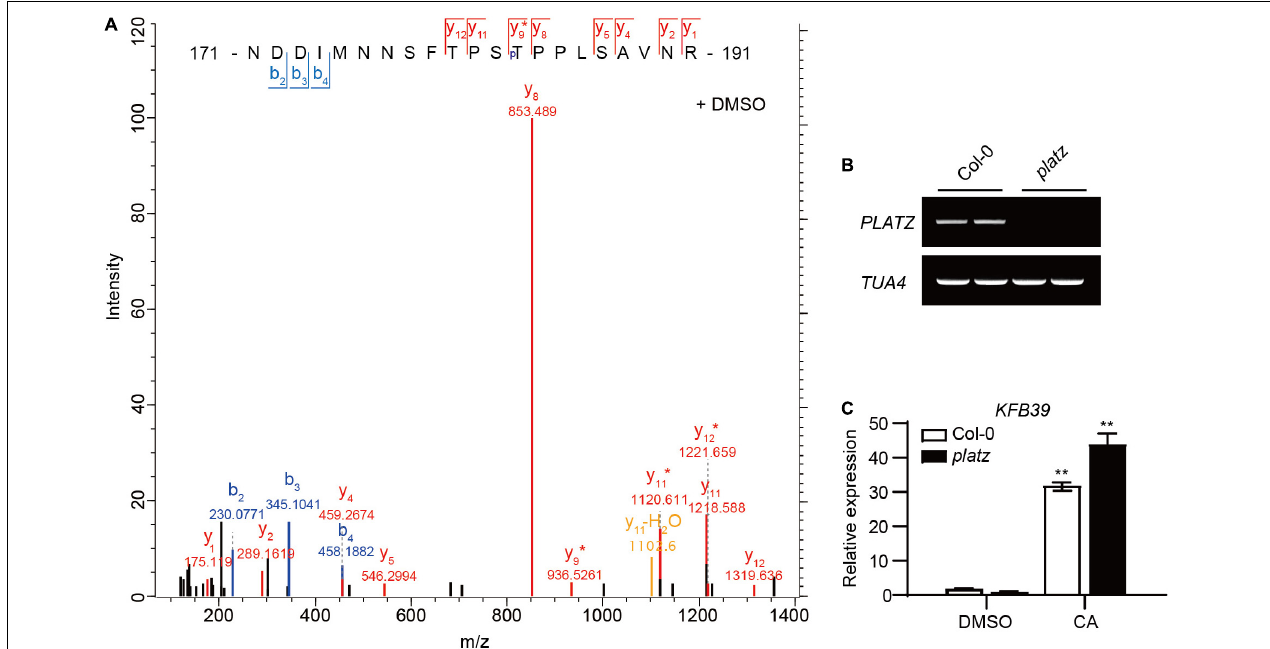
FIGURE 2 | Coniferyl alcohol can induce the up-regulation of KFB39 expression in platz . (A) Mass spectrometric analysis of PLATZ phosphorylation in vivo at Thr 183 in 2-week-old Col-0 seedlings treated with solvent DMSO for 1 h. (B) RT-PCR result showing that the platz was a knock-out mutant line for PLATZ . TUA4 was used as the positive control. (C) The expression level of KFB39 in 14-day-old Col-0 and platz seedlings treated with solvent DMSO or 0.1 mM CA for 30 min. All of the data represent average transcript level values ( ± SD) relative to corresponding DMSO-treated lines. Asterisks indicate a statistically significant difference between the treated and DMSO control groups (Student’s t -test, * P < 0.05, ** P < 0.01, n =